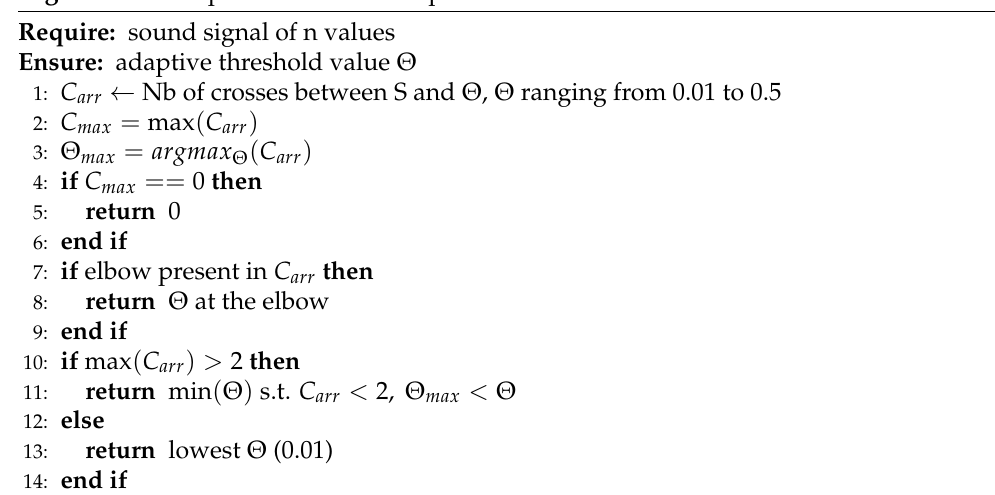
Algorithm 1 Adaptive threshold computation